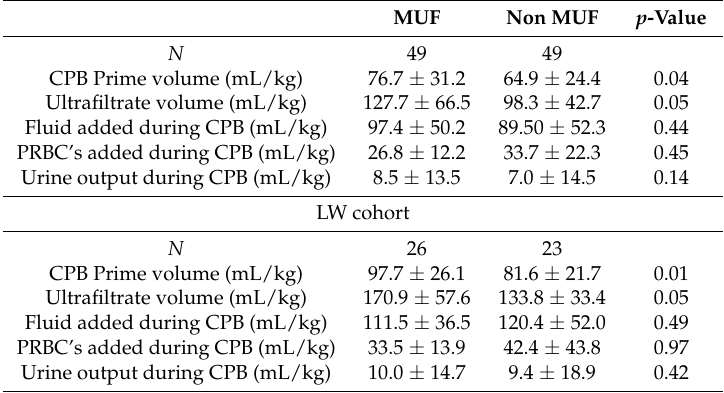
Table 2. CPB and ultrafiltration data.